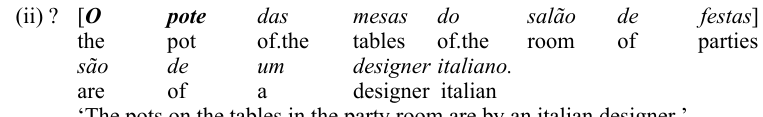
mesas do salão de festas ] of.the tables of.the room of parties são designer